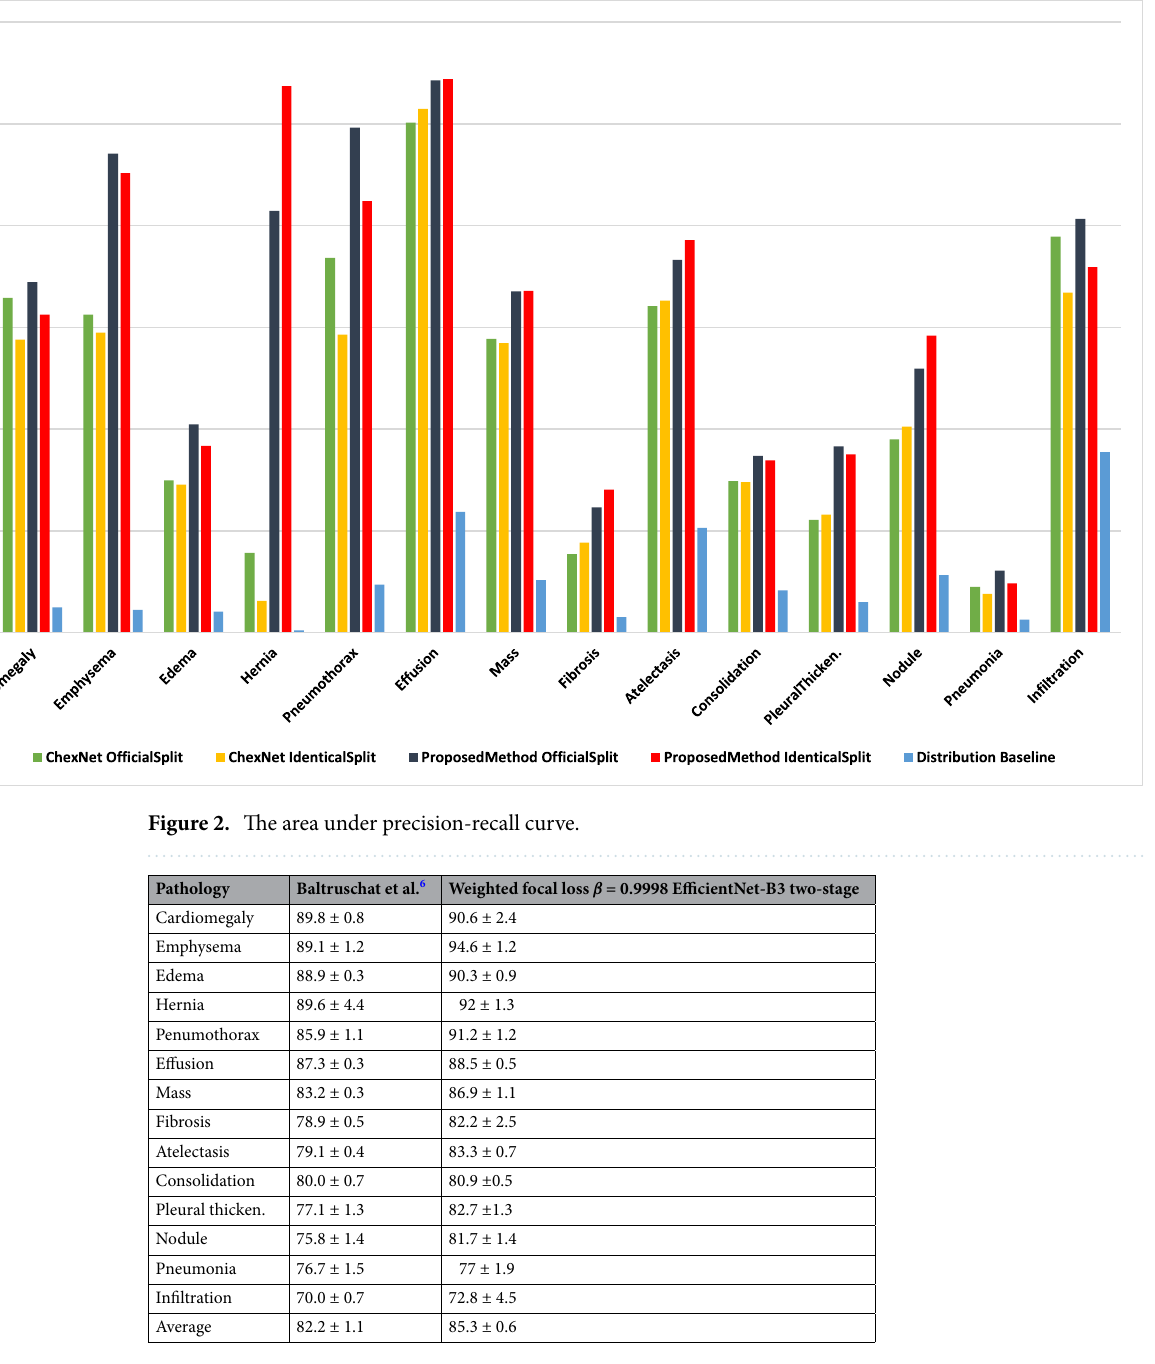
Table 7. Results from fivefolds